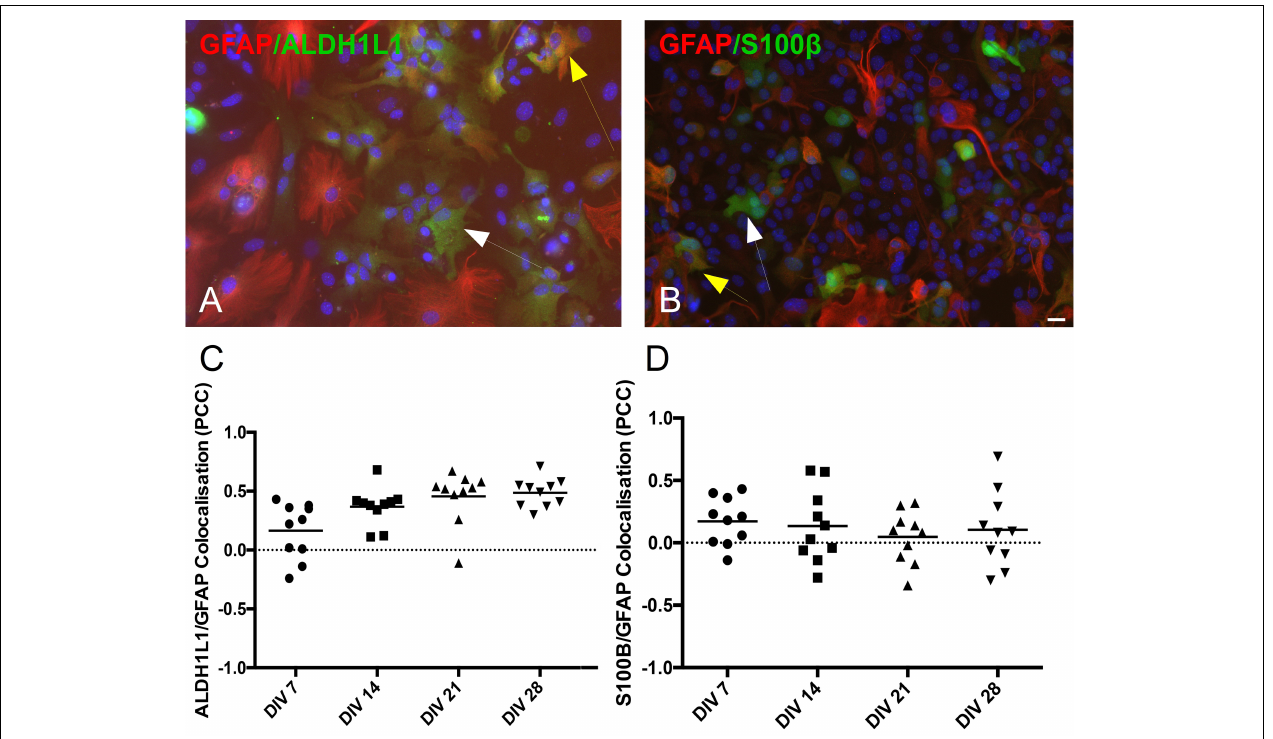
FIGURE 4 | Co-localization of astrocytic markers (GFAP, ALDH1L1, and S100 β ). (A) Culture example at DIV 21 of astrocytes co-expressing GFAP and ALDH1L1 (yellow arrow) or expressing only ALDH1L1 (white arrow). (B) Culture example at DIV 21 of astrocytes co-expressing GFAP and S100 β (yellow arrow) or expressing only S100 β (white arrow). Cell nuclei marker H-33342 (blue stain). Scale bar 20 µ m. (C,D) Analysis of co-localization across different days in vitro reveals heterogeneity of differentiated astrocytes in protein expression. Pearson’s correlation coefficient of GFAP/ALDH1L1 and GFAP/S100 β stains from DIV 7 to DIV